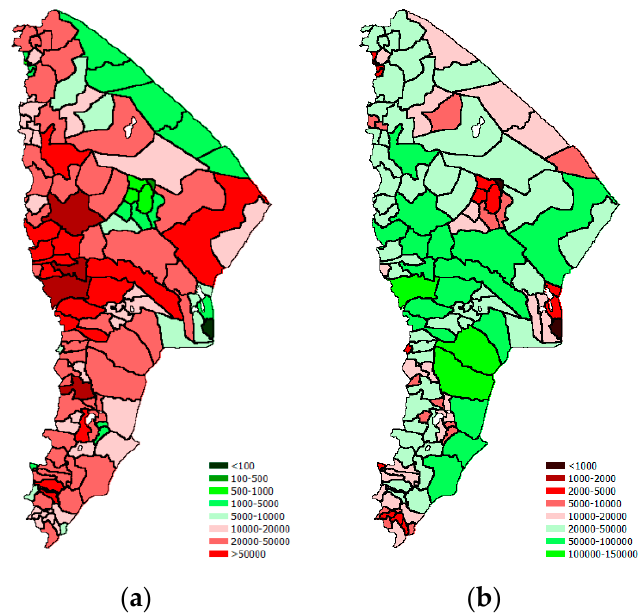
Figure 10. Annual livestock presence in TLU after migration (panel a ), annual fodder supply expressed in TLU equivalents (panel b ) (scale 1:7,200,000).